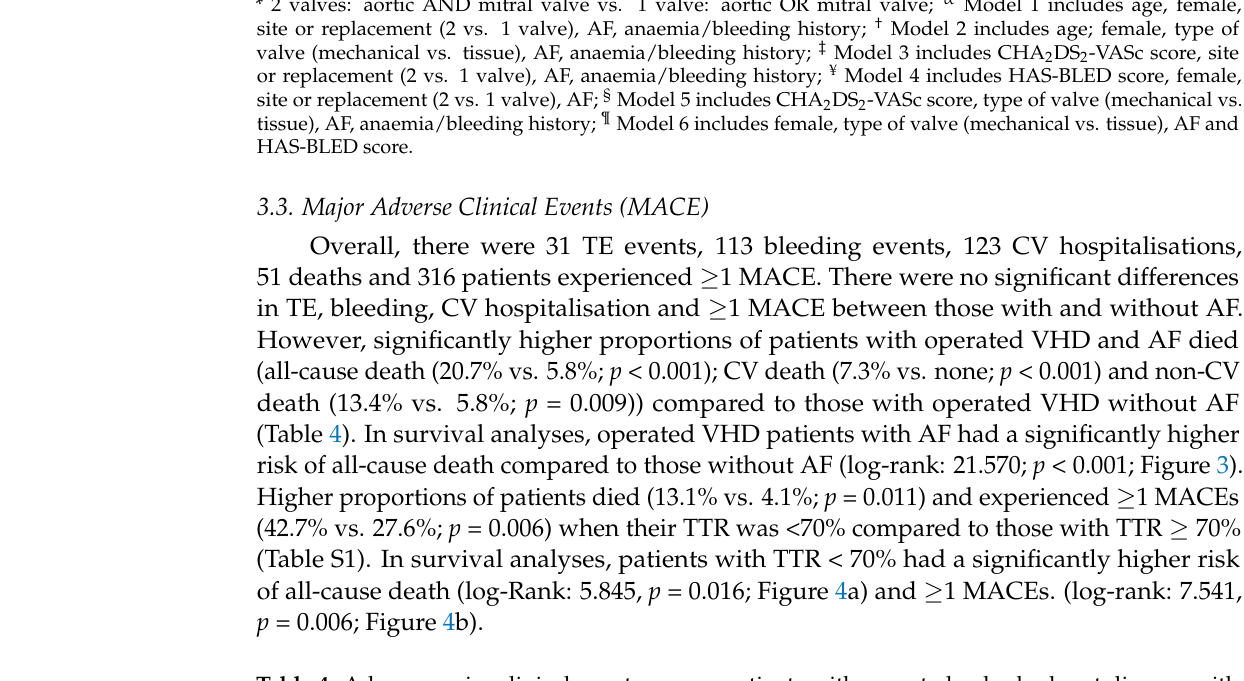
Table 4. Adverse major clinical events among patients with operated valvular heart disease, with and without